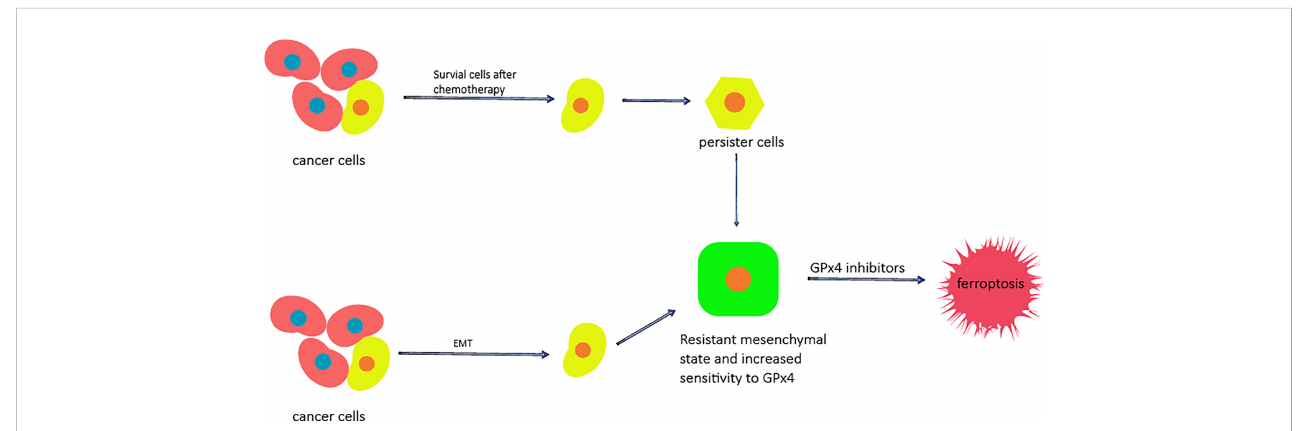
FIGURE 2 The potential of ferroptosis for overcoming cancer cell resistance. The cells that survive after chemotherapy are called persister cells and have mesenchymal characteristics. Mesenchymal markers and stem cell markers are increased, while the levels of GSH, NADPH and Nrf2 are decreased. Cancer cells can enter the mesenchymal state through EMT. In the mesenchymal state, the sensitivity of cells to GPX4 is increased, and the use of GPx4 inhibitors can cause them to